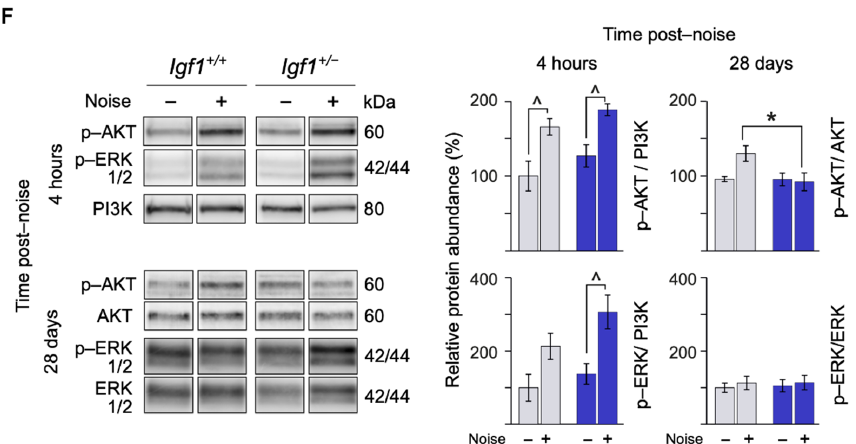
Figure 3. Cellular abnormalities and synaptic marker loss in the organ of Corti of Igf1 +/ − mice after noise exposure. ( A ) Hair cell and synaptic marker loss in the organ of Corti 28 days after noise exposure. ( a – d ) Representative phalloidin (Pha)-stained samples in non-exposed and noise-exposed WT and Igf1 +/ − mice. An unbiased counting frame grid was used for stereological counting that was photographed and is shown superimposed on each image. ( e , f ) Representative microphotographs of haematoxylin-eosin-stained cryosections of noise-exposed WT and Igf1 +/ − mice. Asterisks indicate the absence of HC. ( g , h ) Representative microphotographs of cochlear cryosections showing the organ of Corti of noise-exposed WT and Igf1 +/ − mice, 28 days after noise exposure. Sections were stained for neurofilaments (NF)—in red—and synaptophysi (Syn)—in green—showing at the base of HC nerve fibers and efferent synaptic terminals, respectively. Cellular nuclei were visualized with DAPI. The dashed lines show the approximate outline of selected IHC and OHC. White asterisk in h indicates the absence of synaptophysin. Scale bars: 50 µ m. IHC: inner hair cell, OHC: outer hair cell. ( B ) Quantification of OHC and IHC in non-exposed and noise-exposed WT and Igf1 +/ − mice. Values are presented as mean ± SEM of at least 3 mice per condition. Statistically significant differences were evaluated by the Mann–Whitney U test. (ˆ p < 0.05 vs. baseline condition.) ( C ) The intensity of synaptophysin staining was quantified using ImageJ software. Data were obtained from 11 to 20 sections of at least 3 mice from each condition and are shown relative to those of non-exposed WT mice as mean ± SEM. Statistically significant differences were evaluated by the Mann–Whitney U test (* p < 0.05 between genotypes; ˆ p < 0.05 vs. baseline condition). ( D ) Gap43 cochlear mRNA expression analyzed by RT-qPCR in WT and Igf1 +/ − before ( B ) and 4 h and 3 and 28 days after noise exposure. Gene expression levels were calculated as 2 − ∆∆ Ct (RQ) normalized with data from baseline WT mice group. Values are presented as mean ± SEM of at least 3 mice per condition evaluated in triplicate. Statistically significant differences were evaluated by the Mann–Whitney U test (** p < 0.01 between genotypes; ˆ p < 0.05 vs. baseline group). ( E ) DPOAE threshold (mean ± SEM of at least 4 mice per condition) in non-exposed and noise-exposed WT and Igf1 +/ − mice 28 days after noise exposure. Statistically significant differences were evaluated by the Mann–Whitney U test (ˆ p < 0.05; ˆˆ p < 0.01 vs. baseline condition). ( F ) Cochlear protein relative levels were measured by Western blotting. Representative blots and quantification of levels are shown for p-AKT, p-ERK1/2 cochlear protein extracts 4 h and 28 days post-noise exposure in noise-exposed and non-exposed WT and Igf1 +/ − mice. Expression levels were calculated as a ratio using PI3K or non-phosphorylated forms of AKT and ERK and normalized to non-exposed WT mice group. Values are presented as mean ± SEM of at least 3 mice per condition. Statistically significant differences were evaluated by the Mann–Whitney U test (* p < 0.05 between genotypes; ˆ p < 0.05 vs. baseline